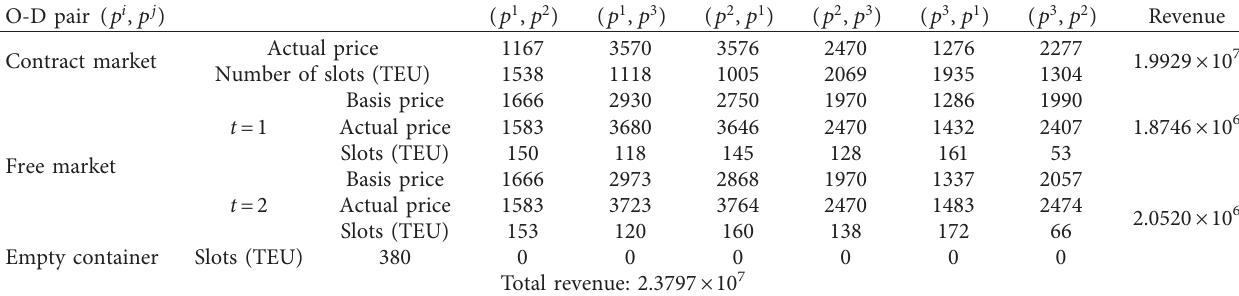
Table 4: Results of slot allocation and actual price for Model